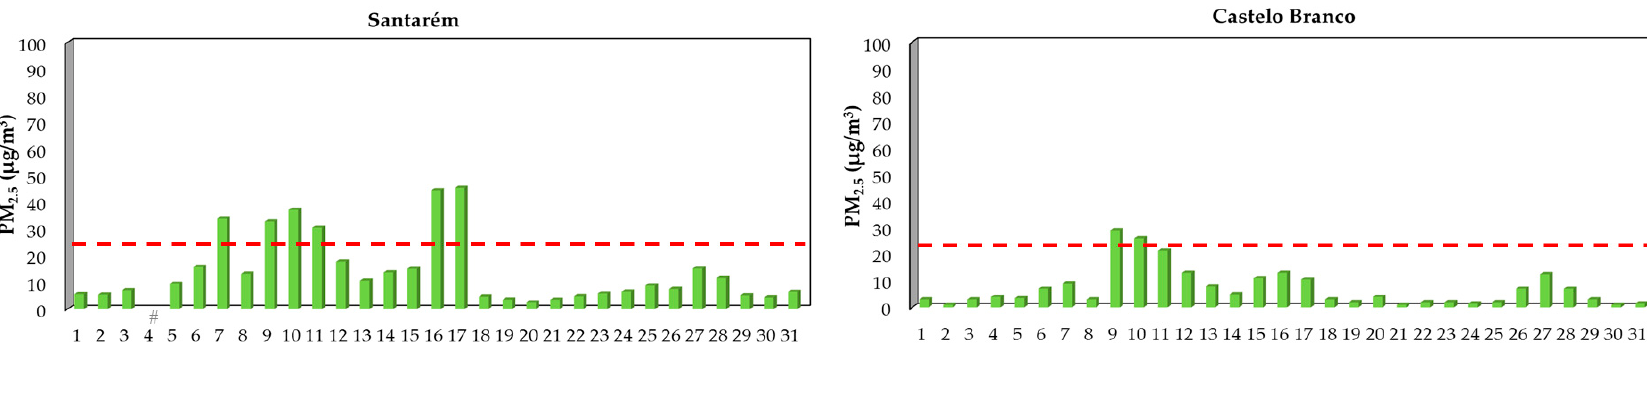
Figure 6. Daily concentrations (median, µg/m 3 ) of PM 10 ( a ) and PM 2.5 ( b ) in the rural monitoring stations from the center region of Portugal during the month of October. Dashed lines represent the WHO guidelines of 50 and 25 µg/m 3 [36] . # Data were not available.